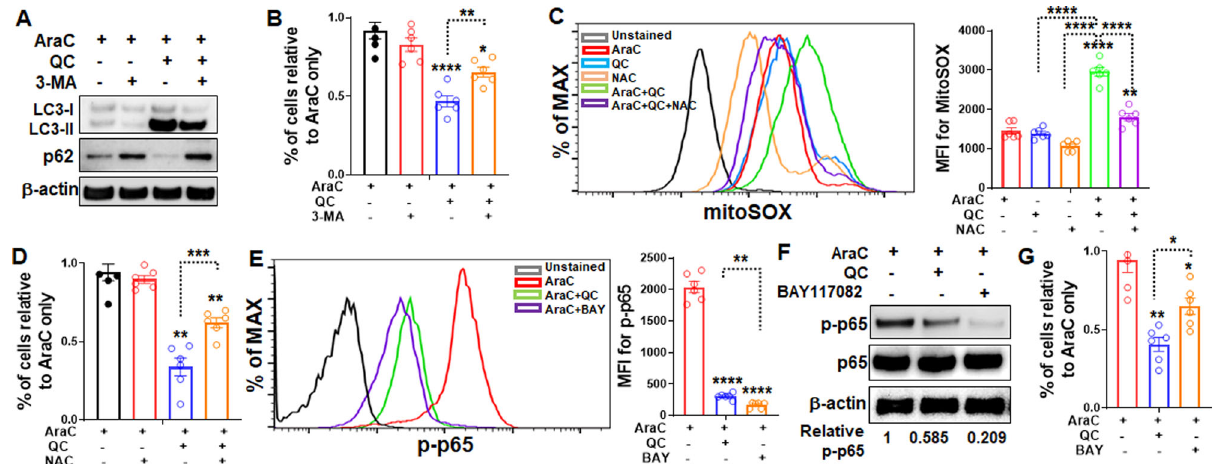
Fig. 5 QC promotes autophagic cell death, increases mitochondrial ROS, and inhibits NF- κ B in AraC-resistant ALL cells. A QC promotes autophagic activity in Molt4-Luc2 cells. AraC-resistant Molt4-Luc2 cells were treated with the indicated agents for 24 h followed by whole-cell lysates (WCL) extraction and western blotting analysis using antibodies against LC3A/B, p62, or β -actin. B Autophagy inhibitor, 3-MA partially abrogates QC-induced cell death. Cells described in ( A ) were enumerated after 24 h of treatment with the indicated agents ( n = 6). C QC increases the production of mitochondrial ROS in ALL cells. AraC-resistant Molt4-Luc2 cells were treated with the indicated agents for 24h followed by Flow cytometry analysis for mitochondrial ROS. Representative histogram (Left) and quanti fi cation (Right) are shown ( n = 6). D Blocking ROS partially abolishes QC-induced cell death. Cells described in ( C ) were enumerated after 24 h of treatment with the indicated agents ( n = 6). E , F QC inhibits NF- κ B activation in AraC-resistant ALL cells. AraC-resistant Molt4-Luc2 cells were treated with the indicated agents followed by fl ow cytometry ( E , n = 6) or western blotting analysis using antibodies against phospho-p65, p65, or β -actin ( F ). Quanti fi cation of the obtained western blots was performed by densitometry on ImageJ. Relative p-p65 are shown. G Cells described in ( E ) were enumerated after 24 h of treatment with the indicated agents ( n = 6). Statistics were performed in the indicated groups: two-sided paired t test (parametric); p values are indicated in Source Data fi les (* p < 0.05; ** p < 0.01; *** p < 0.001; **** p <